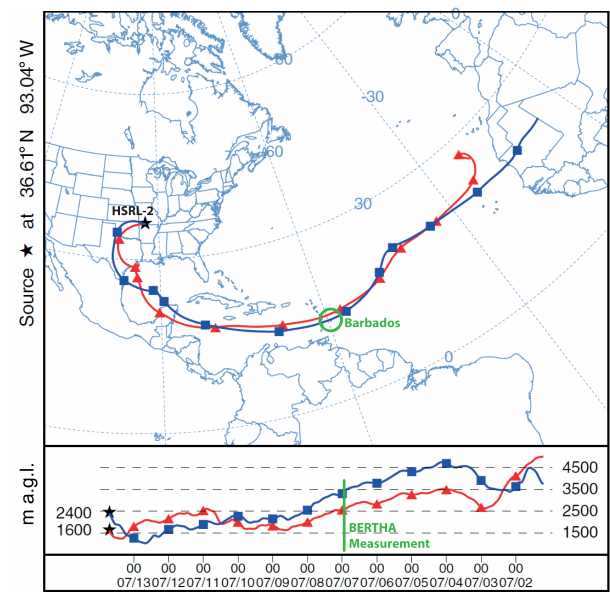
Figure 10. 12.5-day HYSPLIT backward trajectories for 13 July 2014, 17:00UTC, arriving at 1600m (red) and 2400m (blue) over southern Missouri (midwestern United States). The location (Bar- bados) and time of the corresponding BERTHA lidar measurement is indicated by a green vertical